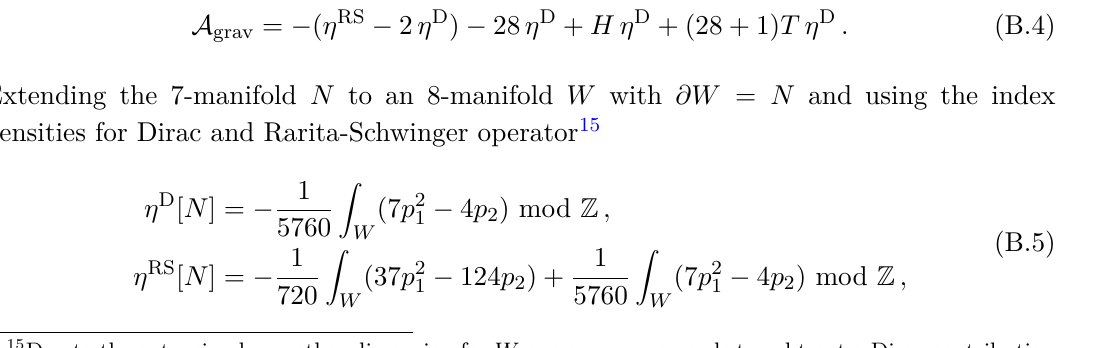
Table 3 . Our monad construction leads to 13 inequivalent Calabi-Yau threefolds with h 1 , 1 = 2 that are genus one fibered over P 2 with a 3 -section. Here we list the corresponding numbers n Z charged, and n uncharged hypermultiples in F-theory, the Euler characteristics χ , the ’t Hooft 3 0 anomaly coefficients l , the triple intersection numbers c bundles V